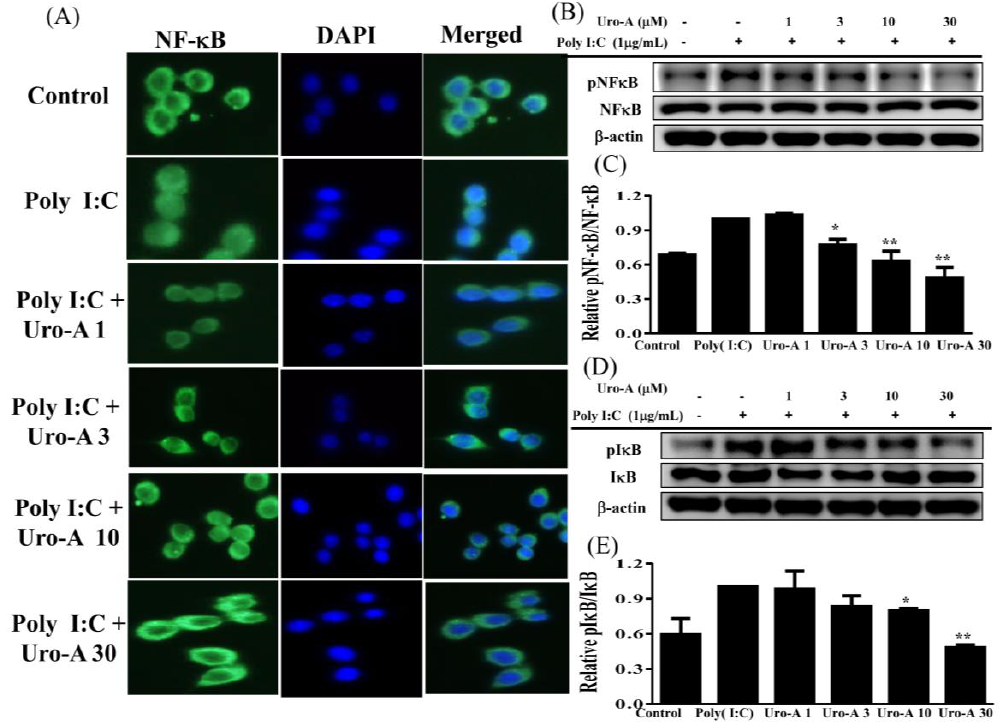
Figure 3. Urolithin A (Uro-A) blocked the NF- κ B activation in poly(I:C)-induced RAW264.7 cells. ( A ) DAPI staining showed that Uro-A inhibited NF- κB p65 from translocating from the cytoplasm into the nucleus. Cells were pre-cultured with Uro-A, and then incubated with poly(I:C) (1 μ g/mL) for 30 min. Immunofluorescent staining was performed to evaluate NF- κB p65 (green) translocation. Blue is nuclear staining with DAPI. ( B ) pNF- κB and NF - κB protein expression. ( C ) Fold-change in